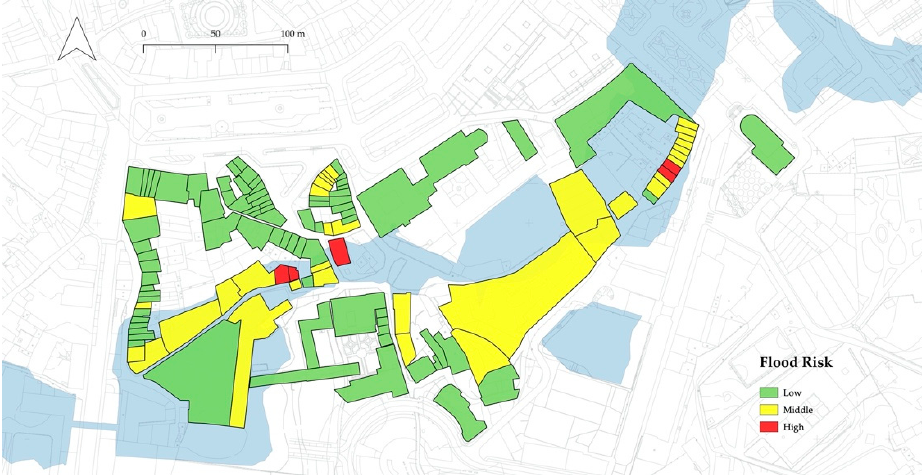
Figure 13. Spatial distribution of the flood risk results.